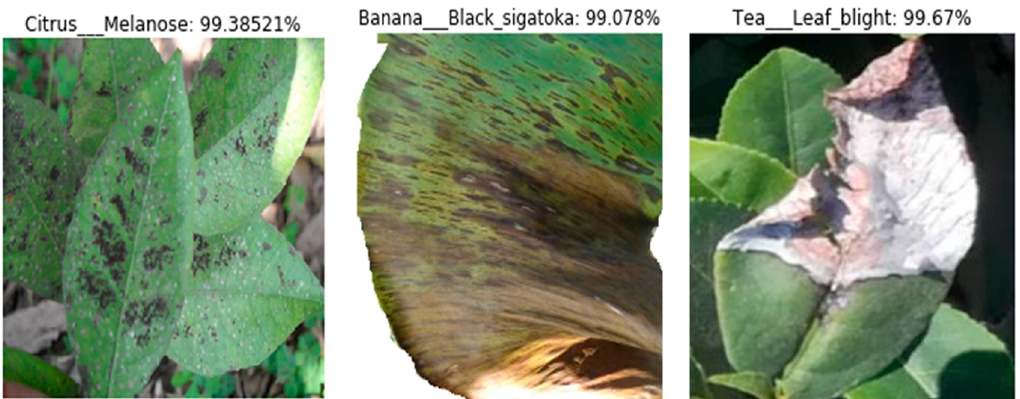
Figure 4. Sample predicted images using the 14-DCNN model.